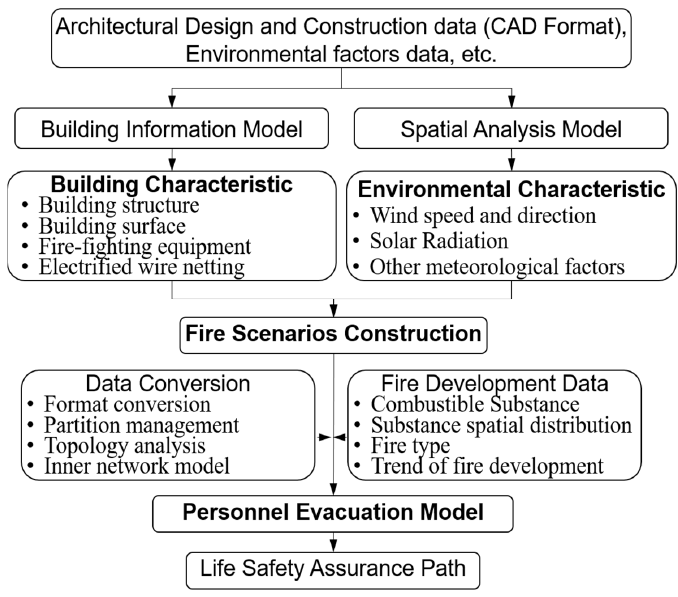
Figure 1. Overall